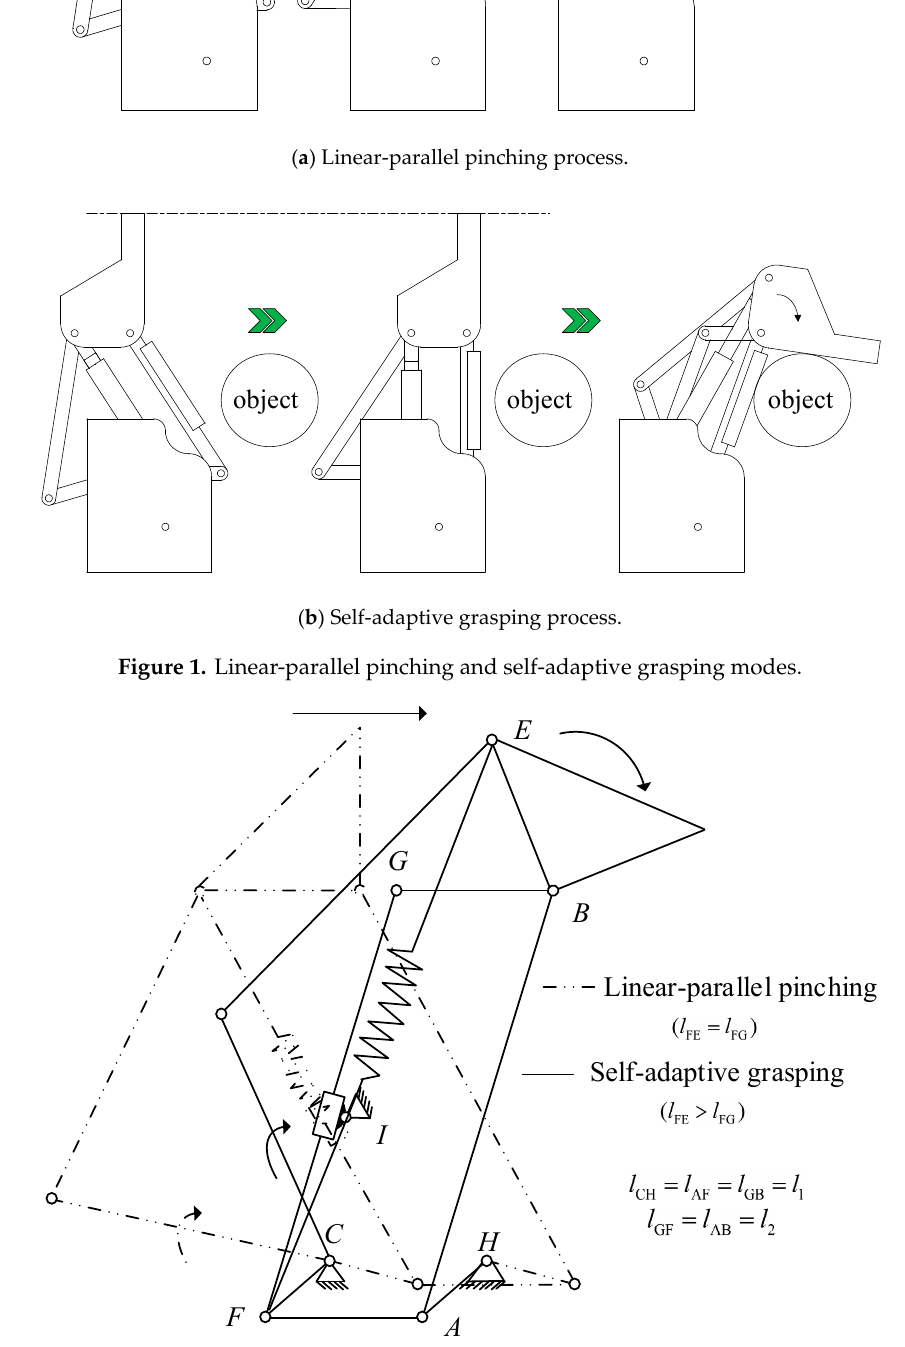
Figure 2. The working principle of the finger mechanism.